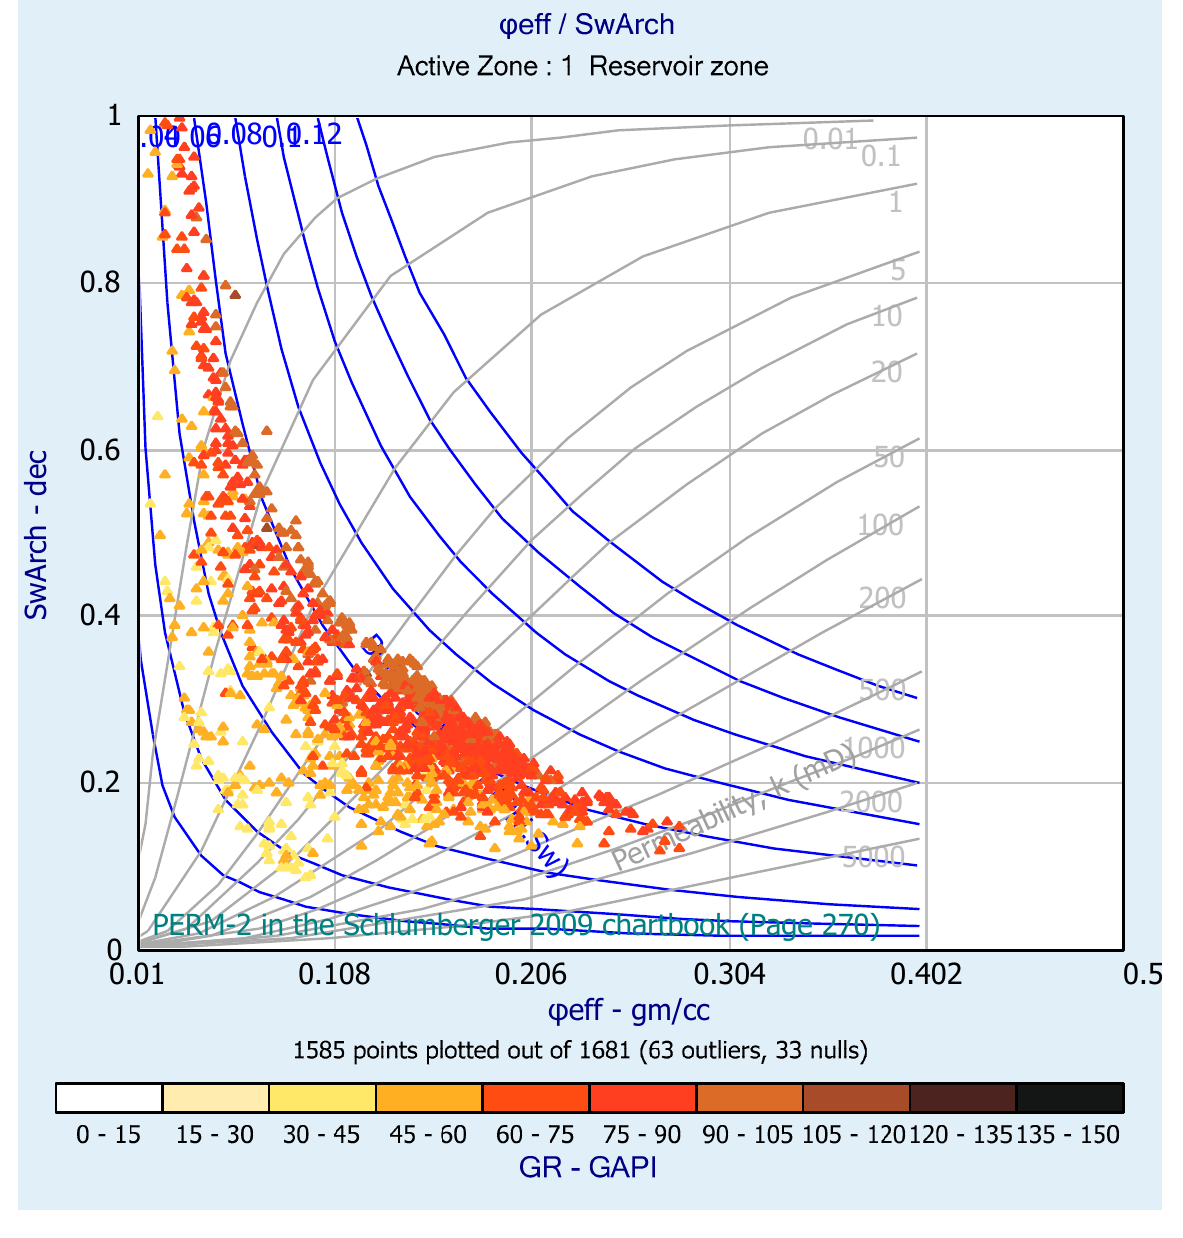
Figure 10. QGF well 03 Buckles plot.